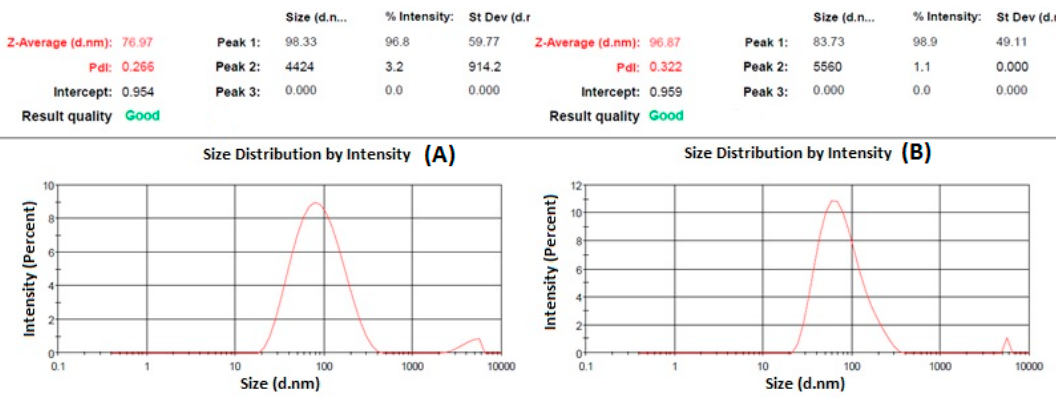
Figure 1. Represent particle size and particle size distribution of blank nanoparticles (NPs) ( A ) and naringenin-loaded chitosan nanoparticles (NAR NPs) ( B ) measured by zetasizer.